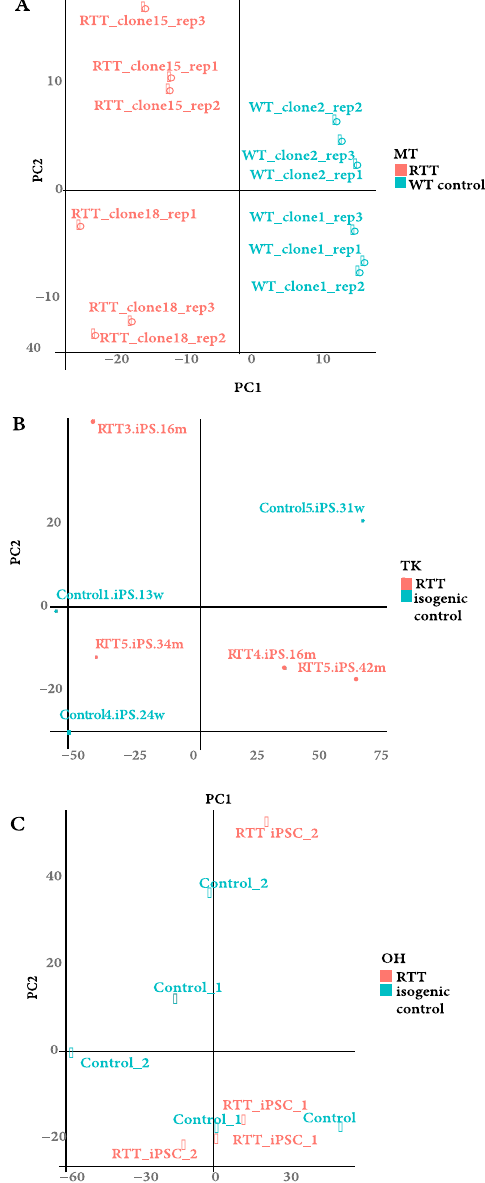
Figure 3. PCA plots for individual datasets showing sample distribution. ( A ). MT dataset showing sample distribution of RTT iPSCs clones 15 and 18 and wild type controls from healthy controls. ( B ). TK dataset sample distribution, RTT iPSCs and their corresponding isogenic controls. ( C ). OH dataset sample distribution, RTT iPSCs, and their isogenic controls.